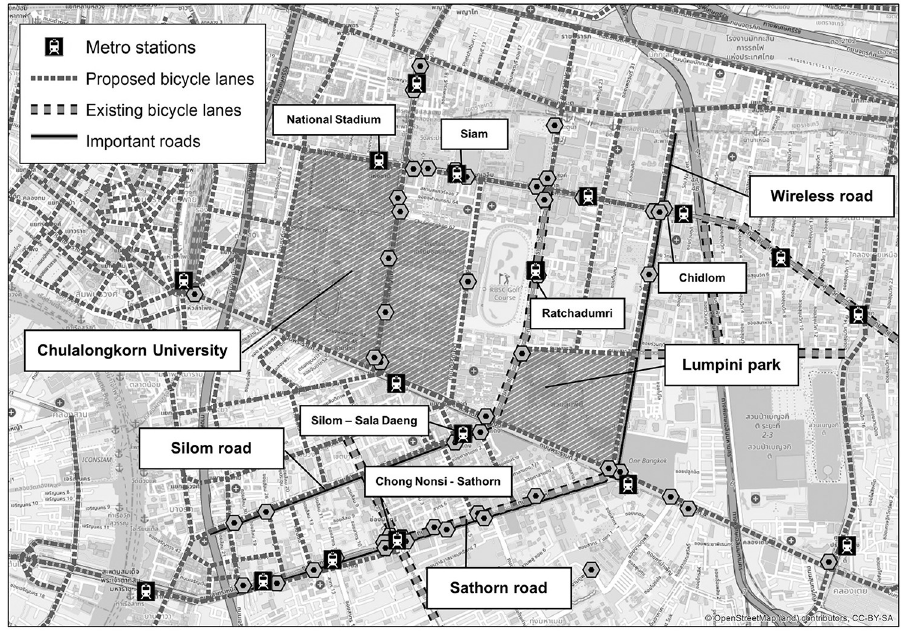
Fig 1. Locations of Pun Pun’s stations and important places in their vicinity. The figure contains a base map from OpenStreetMap and OpenStreetMap Foundation, which is made available under the Open Database License.